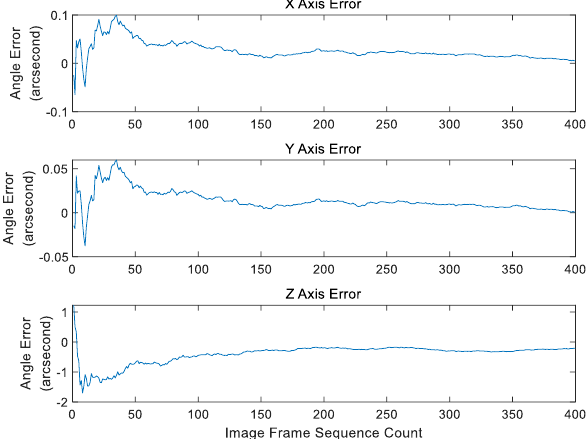
Figure 6. Deviation angle error (arc-second) estimation with frame in σ s = 0.10, σ c = 1.0 (pixel).